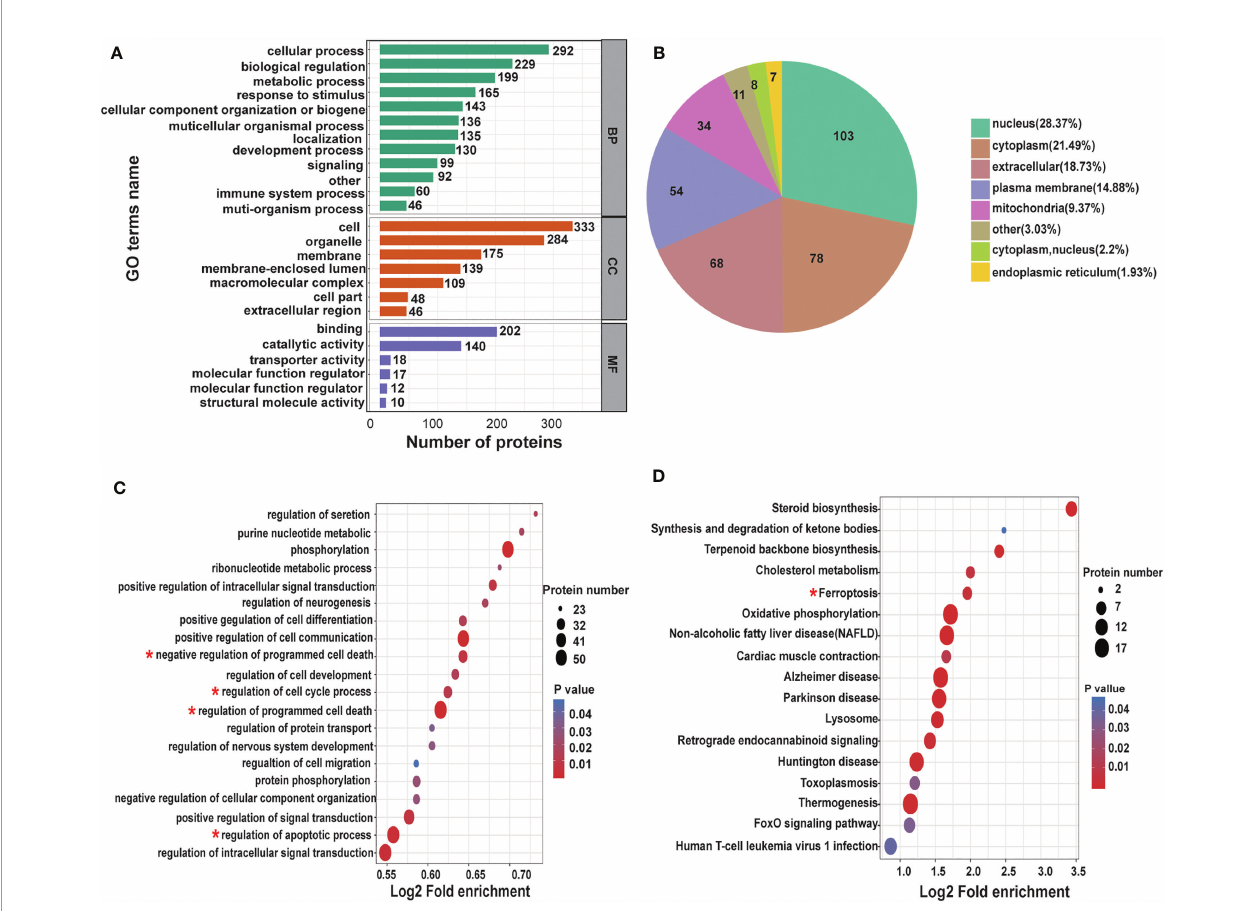
FIGURE 4 | Differentially expressed proteins under the presence of CNC extract in HCT116 cells analyzed by GO and KEGG. (A) BP, CC, and MF evaluated. (B) Subcellular localization and classi fi cation of differentially expressed proteins. (C) GO enrichment analysis of BP. (D) KEGG pathway enrichment